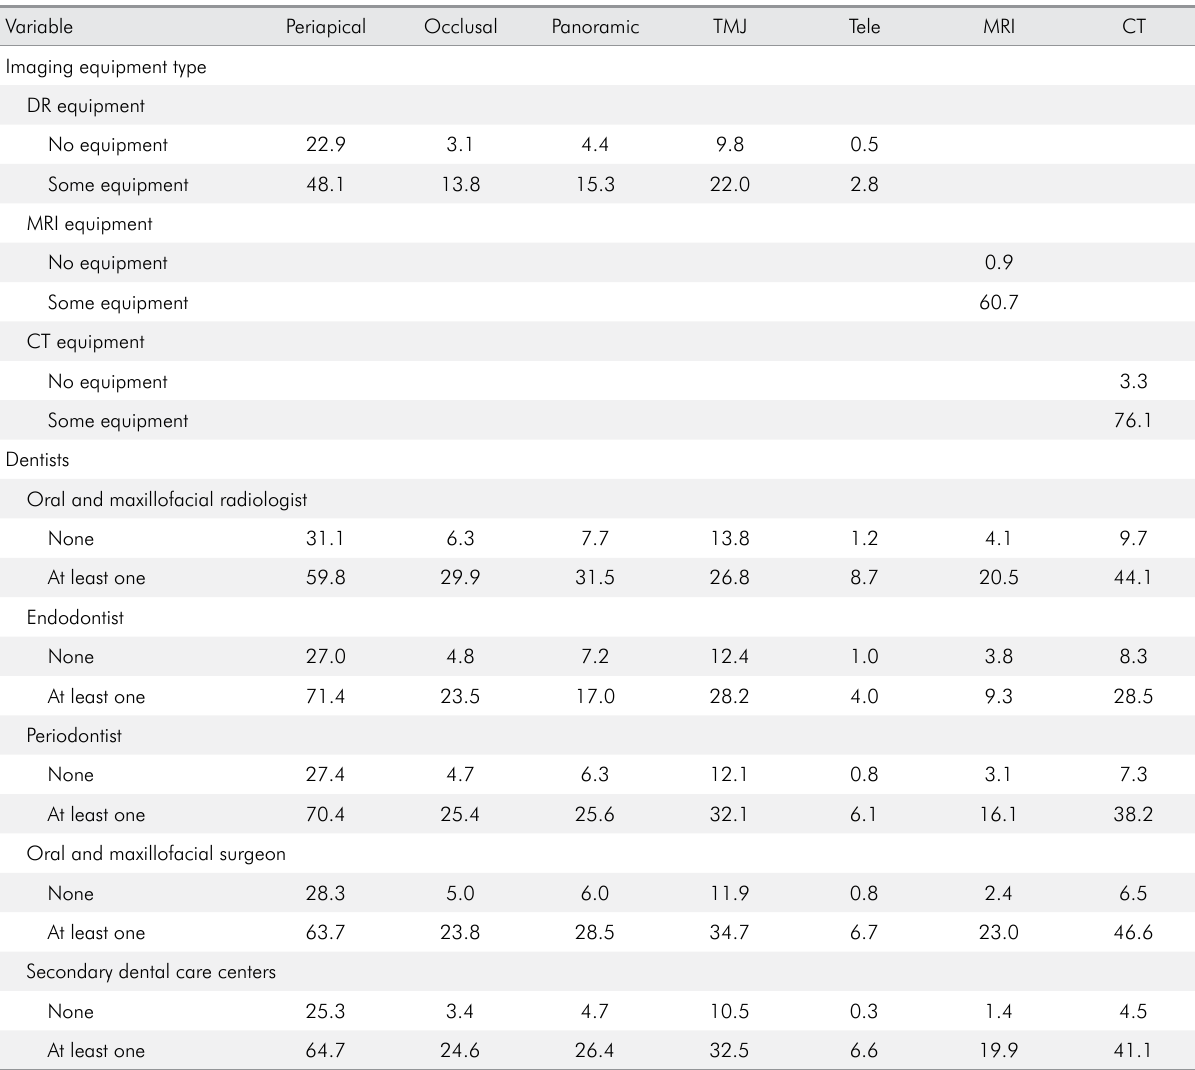
Table 3. Percentage of municipalities that increased the rates of imaging procedures per 100,000 inhabitants from 2005–2007 to 2014–2016 by equipment type and